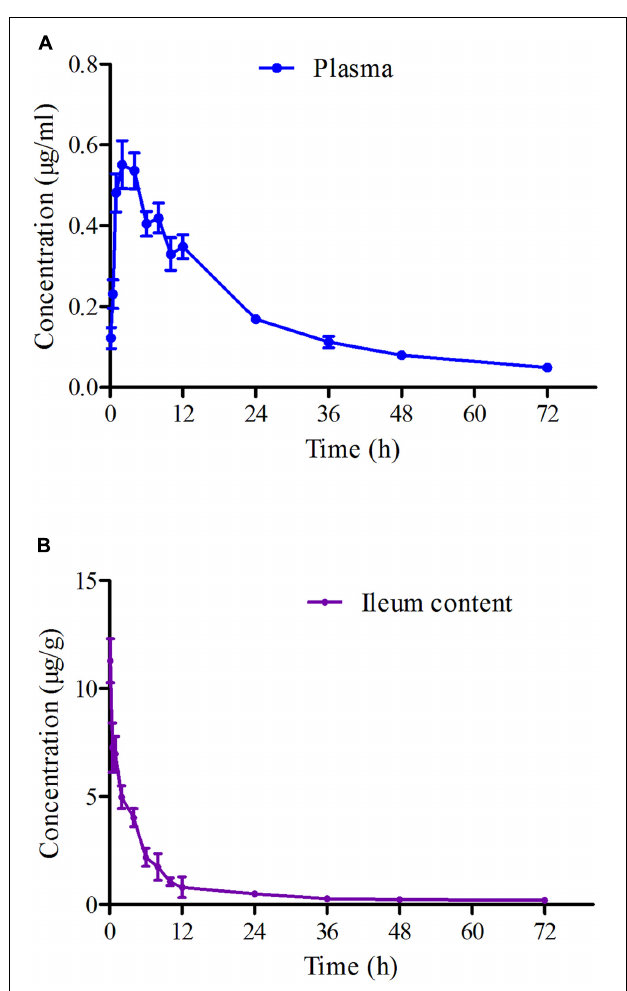
FIGURE 5 | The curves of MBF concentration-time in plasma and ileum content of pigs at a dose of 2 mg/kg after oral administration at 0.25, 0.5, 1, 2, 4, 6, 8, 10, 12, 24, 36, 48, and 72 h. (A) Represented the curve in plasma; (B) represented the curve in ileum content.